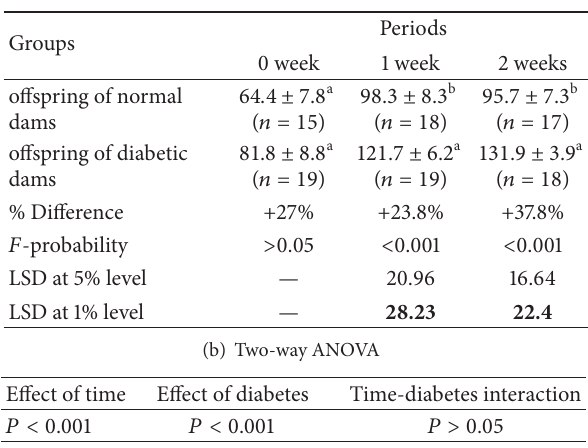
Table 1: Serum glucose concentration of offspring of normal and diabetic dams at different experimental periods.